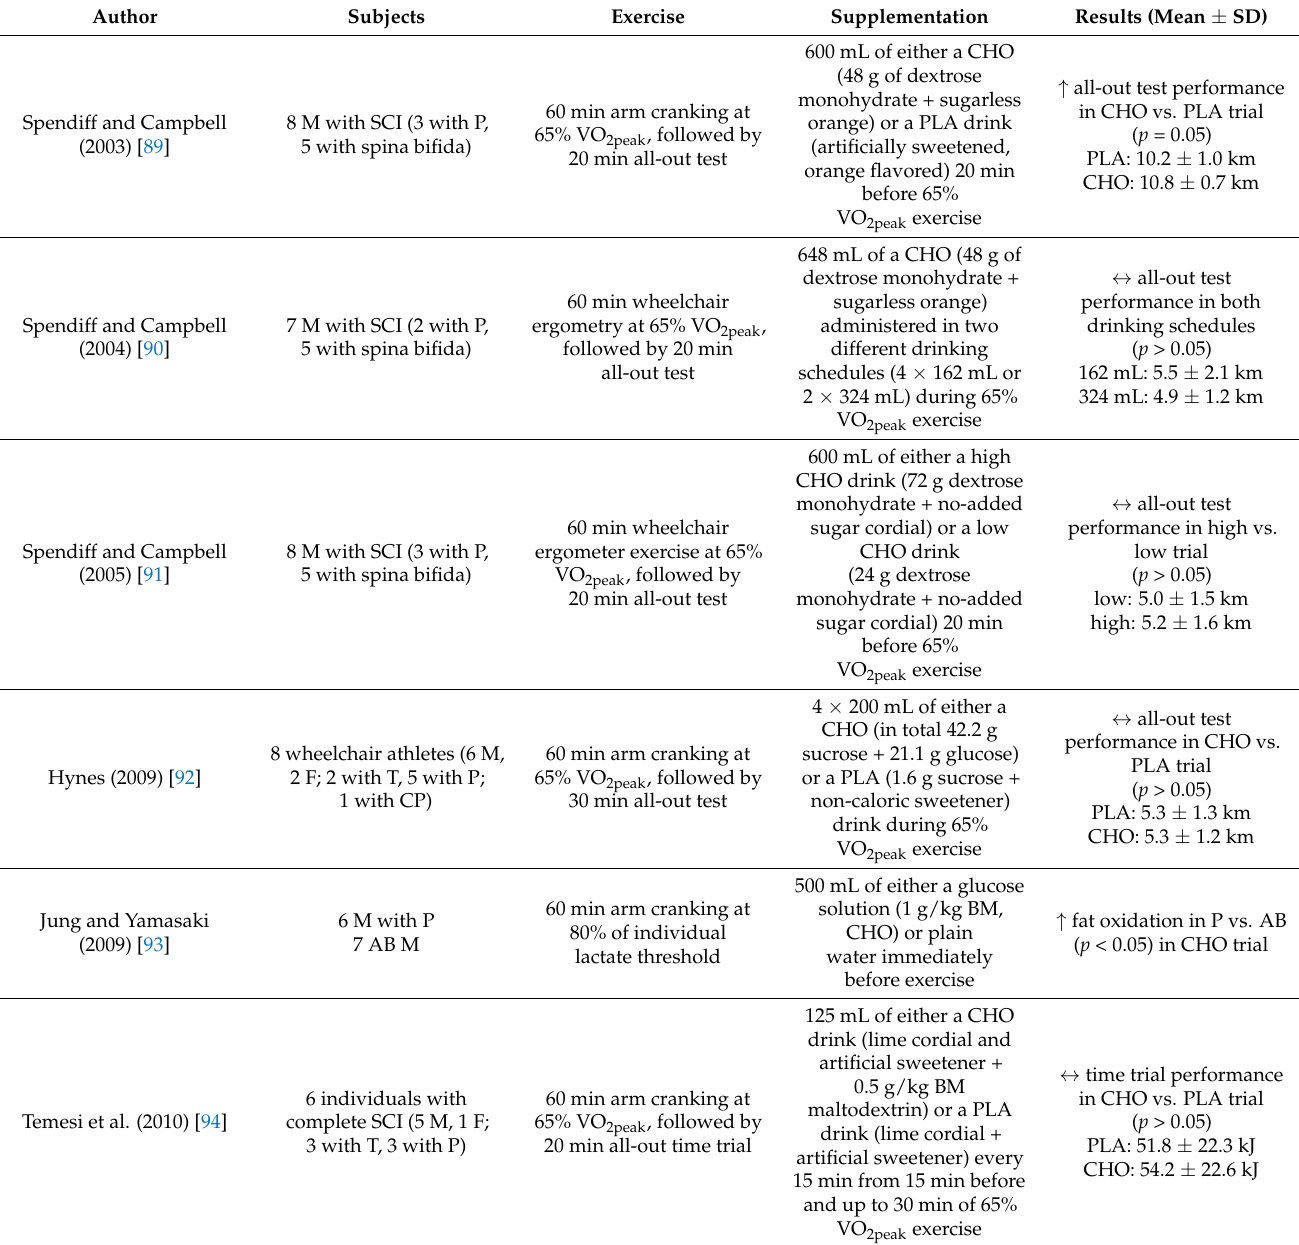
Table 3. CHO supplementation in individuals with an